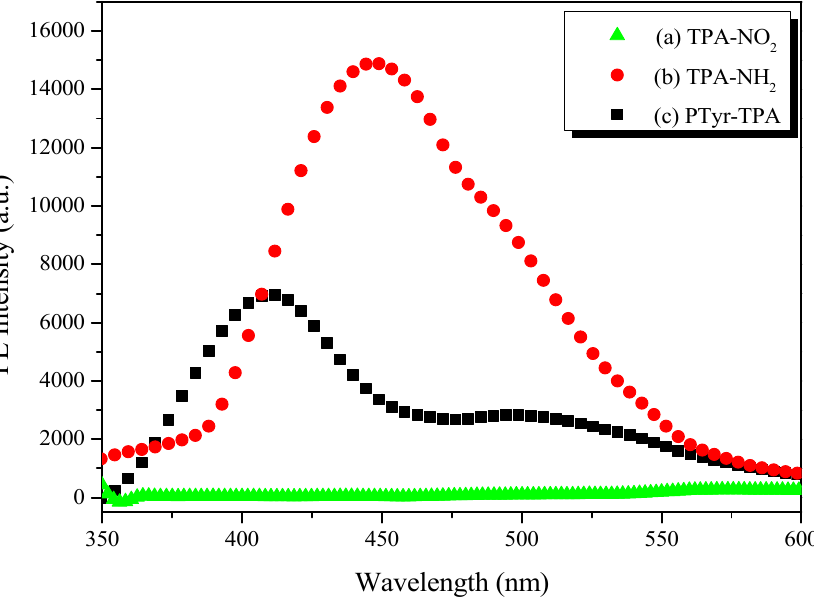
Figure 5. PL spectra (excitation wavelength: 330 nm) of: ( a ) TPA-NO 2 ; ( b ) TPA-NH 2 ; and ( c ) PTyr-TPA in the solid state.